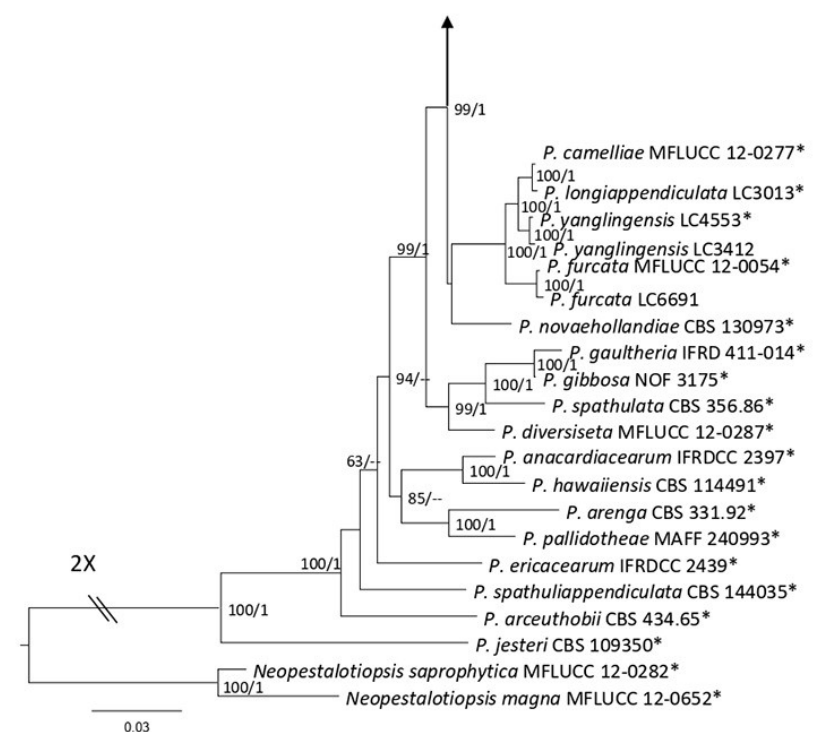
Figure 13. Bayesian phylogenetic tree of Pestalotiopsis spp. obtained from the combined ITS, tef1 , and tub2 sequence data. The ultrafast maximum likelihood bootstrap support (%) ≤ 50 and BYPP ≥ 0.95 are shown at the nodes. The ex-type strains are marked with an asterisk. The tree is rooted in Neopestalotiopsis saprophytica (MFLUCC 12-0282) and N. magna (MFLUCC 12 - 0652 ).